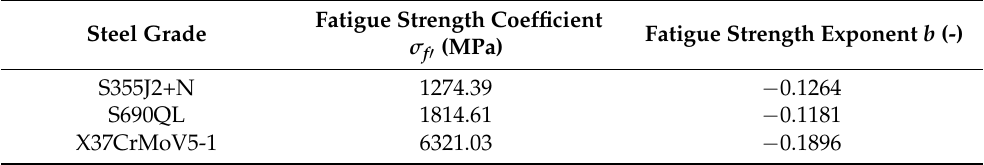
Table 4. Fatigue properties under uniaxial stress-controlled fully reversed testing, stress ratio R = − 1.